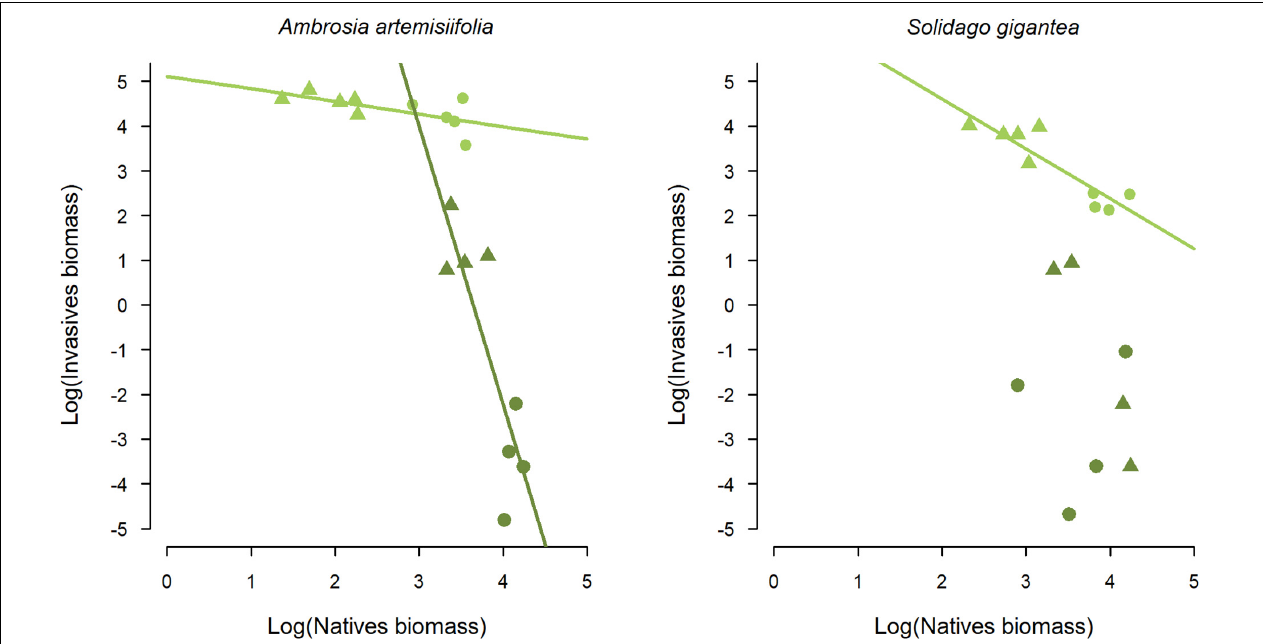
FIGURE 2 | Native species biomass effect on the invasive alien Ambrosia artemisiifolia and Solidago gigantea . Linear model A . artemisiifolia : adjusted R 2 = 0.96, P < 0.0001; Linear model S . gigantea : adjusted R 2 = 0.91, P < 0.0001. Ln biomass values for the FG1 communities are indicated in dots, with triangles for the FG2 community. Light green symbols indicate simultaneous arrival of native and invasive species, dark green symbols show results for late arrival of the invasive species.